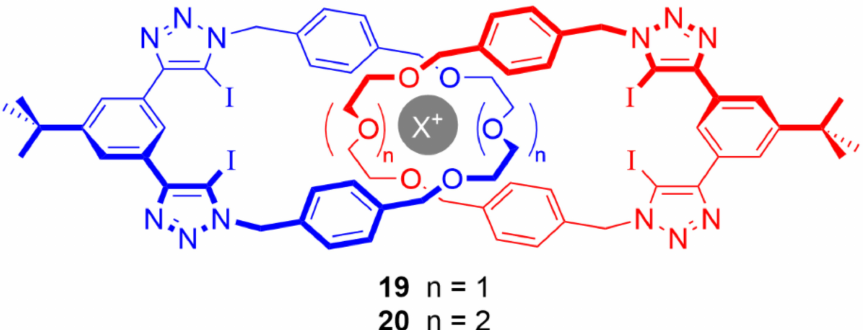
Figure 15. Beer and co-workers’ alkali metal cation templated catenanes 19 and 20, capable of solution phase binding, and extraction of, ion